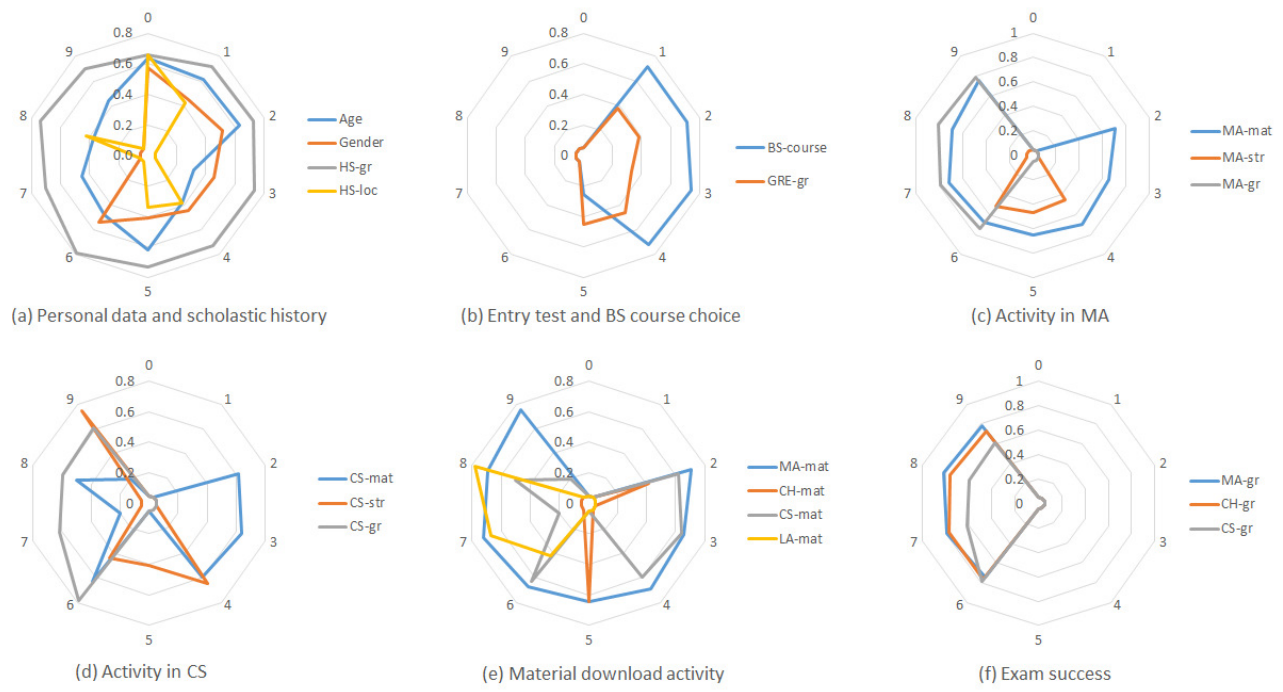
Figure 4. LA: Analysis of the relevance of single features.